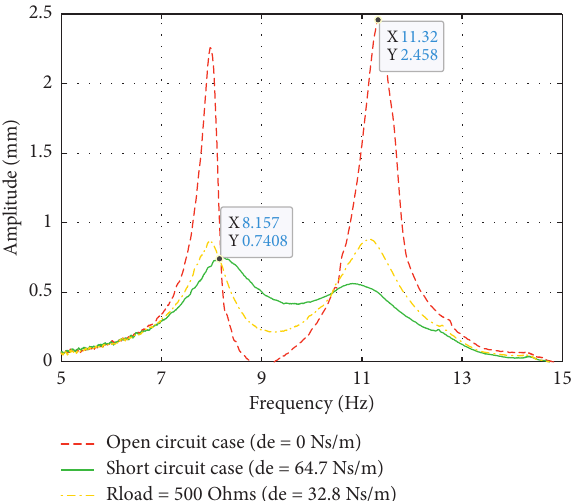
Figure 8: Protected structure with passive TMD amplitude-frequency response.